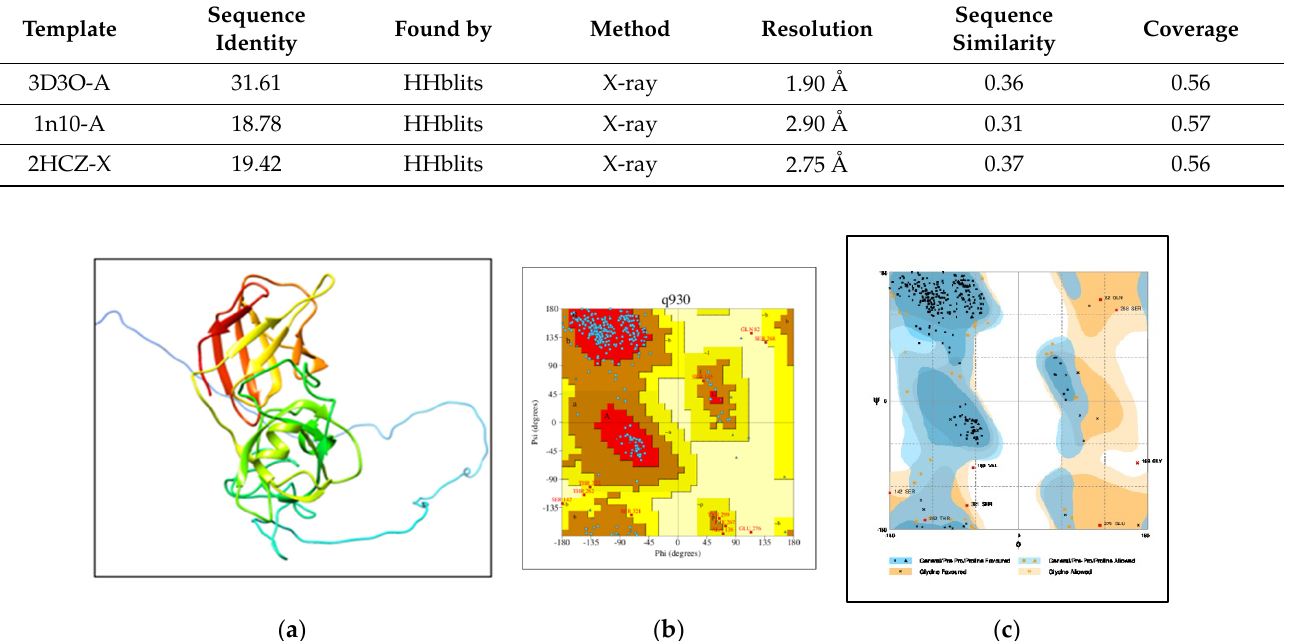
Table 2. Template search results from SWISSMODEL.